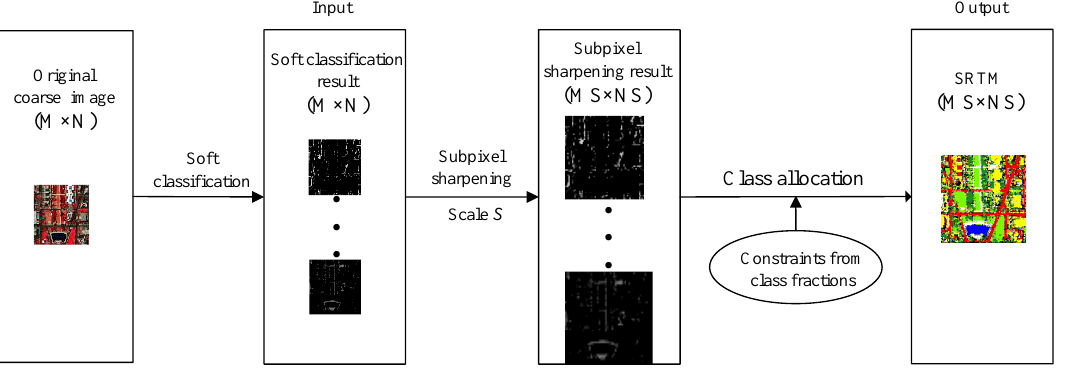
Figure 2. The flowchart of soft-then-hard super-resolution mapping (STHSRM). SRTM, sub-pixel resolution thematic map.